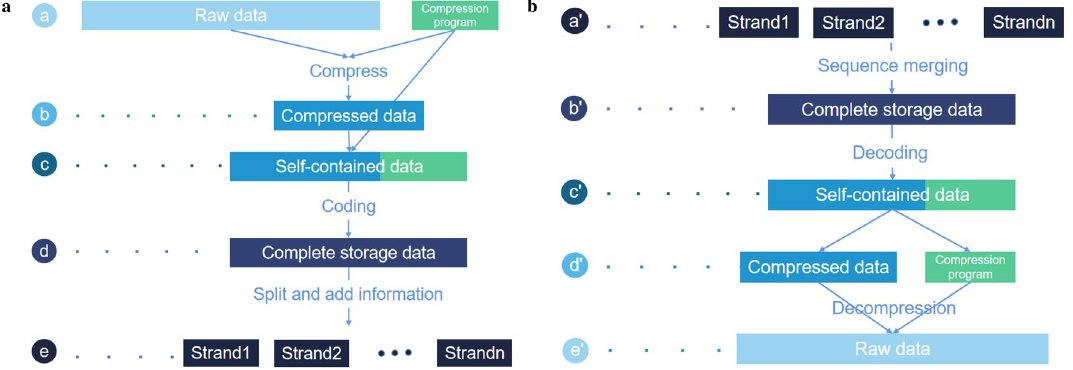
Figure 2. DNA storage process. ( a ) Shows how the dataflow is changed at each stage of the process. The compressed data ( b ) and the decompression program constitute the self-contained data ( c ), which can be simply combined into a single continuous file. However, this change might cause some problems, we will describe them in details later. After encrypting, encoding, and error correcting, we can obtain a long DNA sequence ( d ), which is then split into a set of short sequences ( e ), which are finally stored through the artificial synthetic process. In contrast, ( b ) shows how the dataflow change with respect to the reading process. The fragments are first merged into a complete long sequence (b’), which is then decoded to obtain the corresponding self-contained data (c’). The self-contained data is split into compressed data and a compression encoded program (d’), which is used to